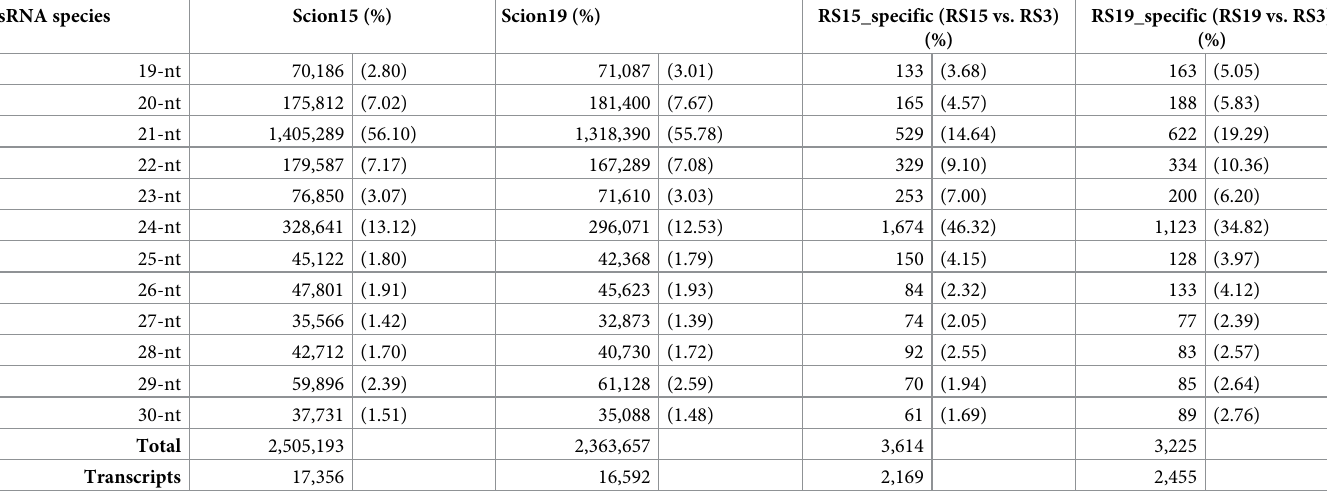
Table 3. The number and fraction (%) of sRNAs in sweet cherry scions and potential scion-to-rootstock transferred sRNAs. sRNA